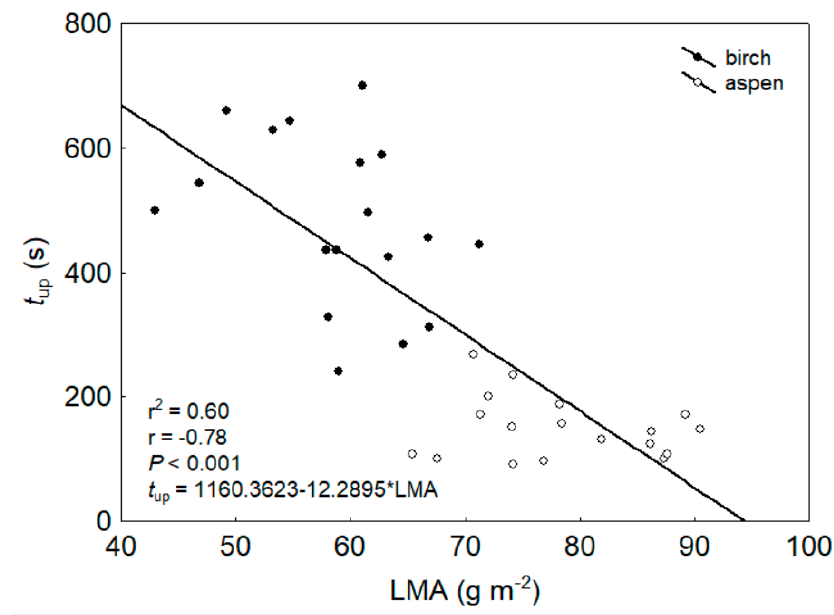
express statistically significant ( p < 0.01) differences between the means.